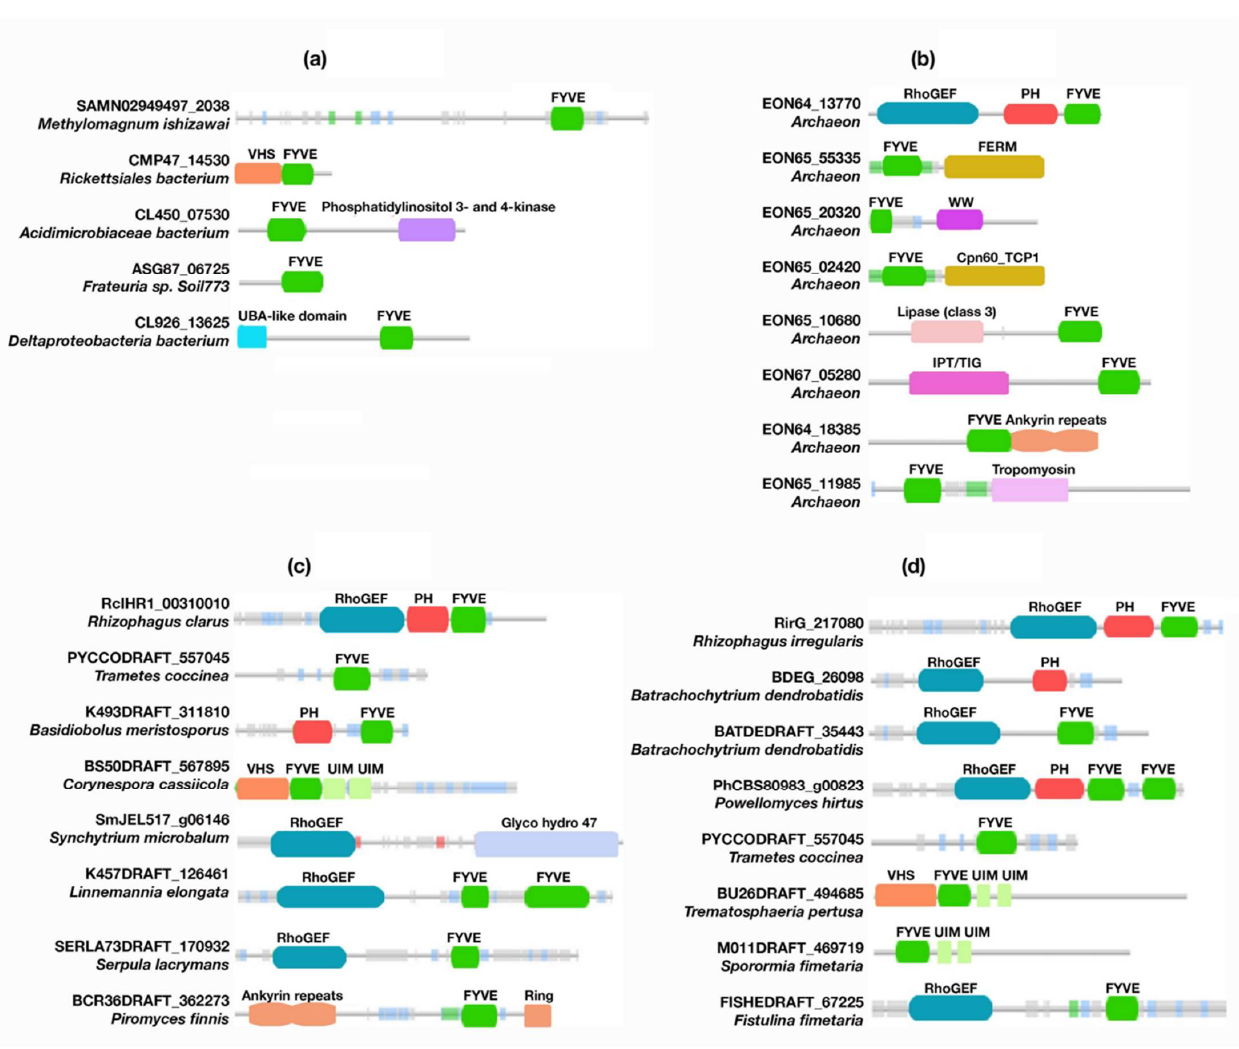
Figure 4. Schematic representation of PH- and FYVE-containing domains found in proteins from bacteria ( a ), archaea ( b ), fungi ( c ), and plants ( d ). Other unique domains are also